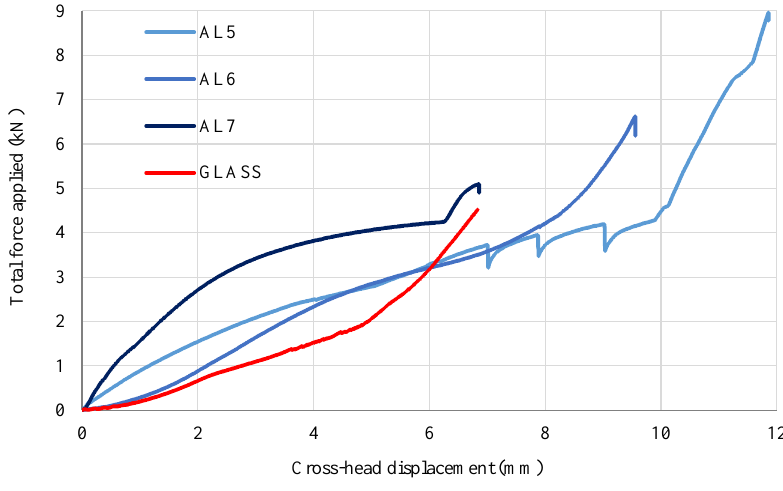
Fig. 3 Force-displacement graph for preliminary tests with aluminium and glass samples, setup